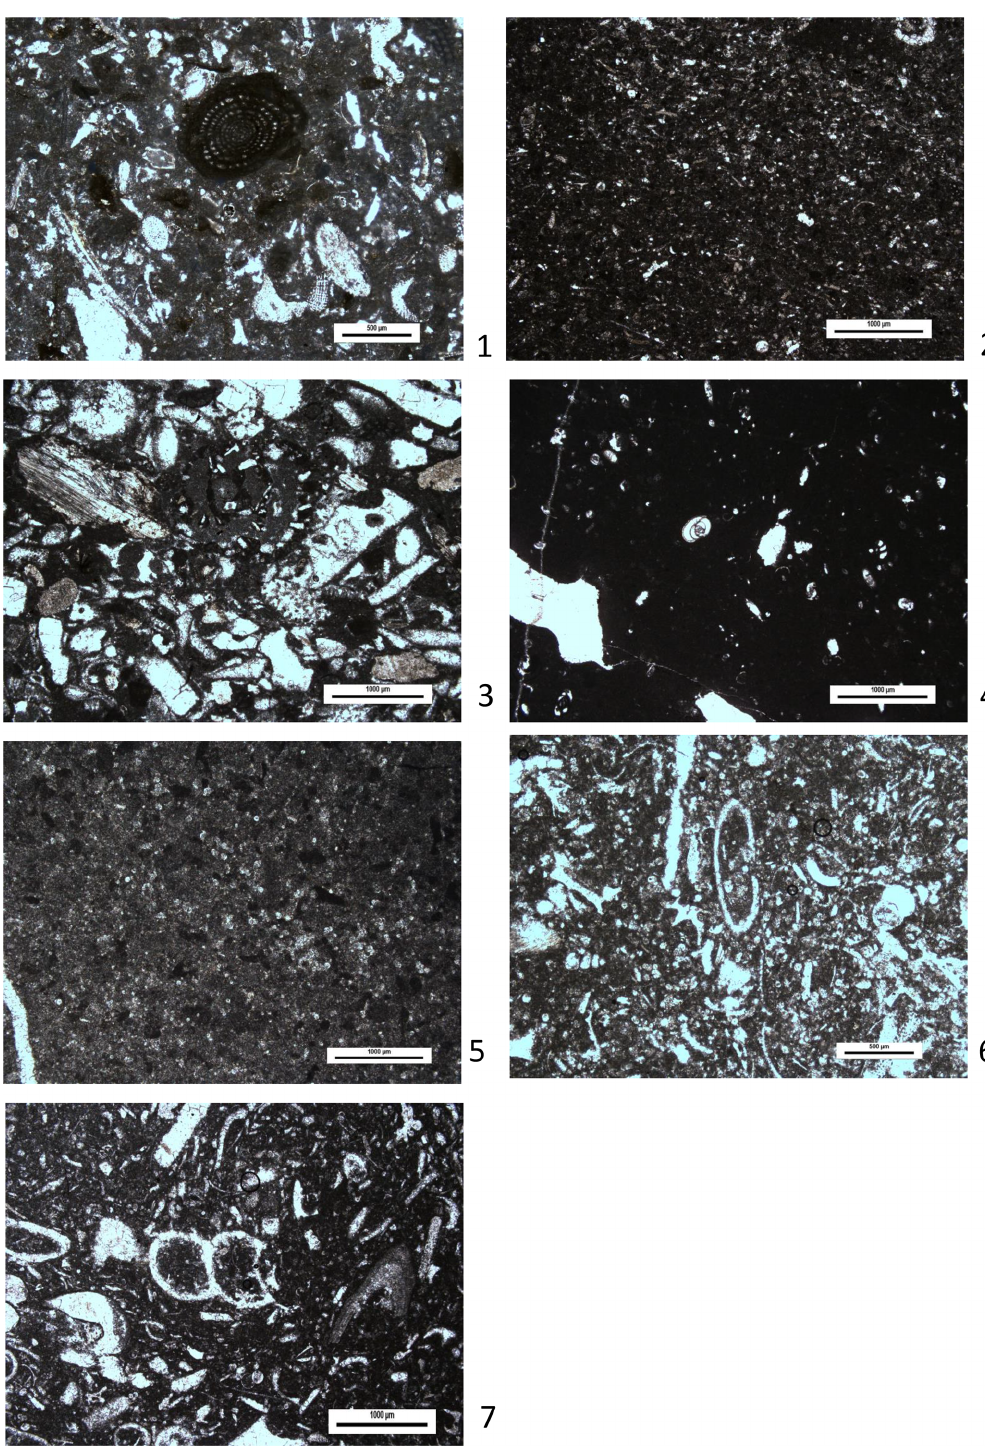
Figure 6. Derdere Formation microfacies: (1) DRK30 – bioclastic wackestone with mollusc and echinoderm debris, planktonic foraminifera, and alveolinid foraminifera; (2) DRK34 – fine peloidal wackestone – packstone with rare planktonic foraminifera; (3) DRK35 – coarse bioclastic packstone, mostly mollusc (?rudist) debris, and lituolid foraminifera; (4) DRK39 – fenestral mudstone – wackestone with miliolid foraminifera and ostracods; (5) DRKA8 – bioclastic mudstone – wackestone with calcispheres and planktonic foraminifera; (6) DRK7(U) – bioclastic wackestone – packstone with calcispheres and mollusc debris; (7) DRK10(U) – bioclastic wackestone with mollusc debris, planktonic foraminifera, and calcispheres. The scale bar is 1000µm, except for in (1) and (6) , where it is 500µm.